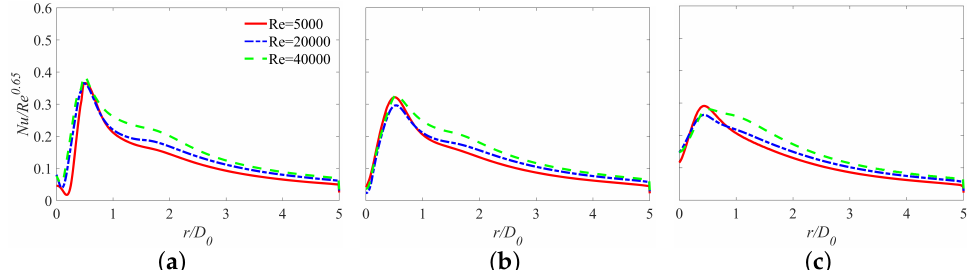
Figure 23. Nusselt number and Reynolds number scaling relationships for the converging nozzle at ( a ) H = 0.5, ( b ) H = 2, and ( c ) H =